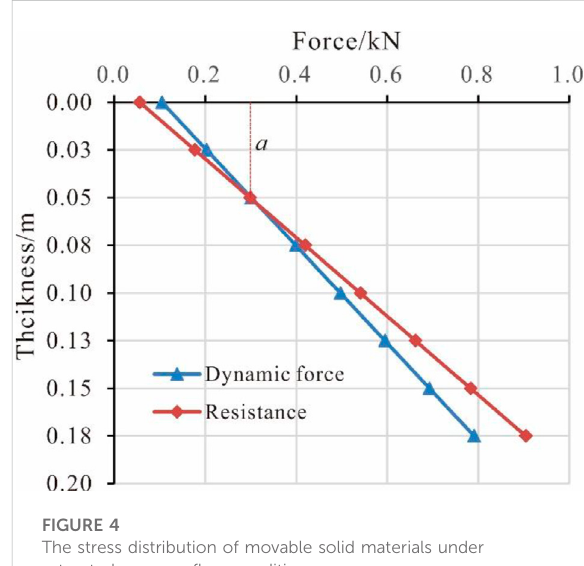
FIGURE 4 The stress distribution of movable solid materials under saturated seepage fl ow